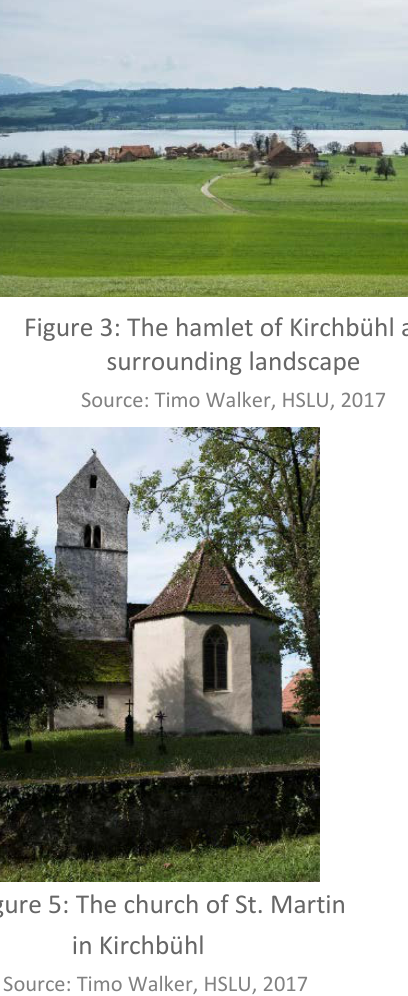
Figure 5: The church of St. Martin in Kirchbühl Source: Timo Walker, HSLU,